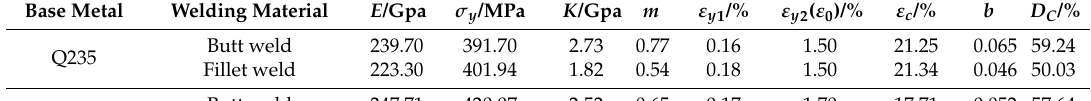
Table 4. Parameter values of initial loading curve.